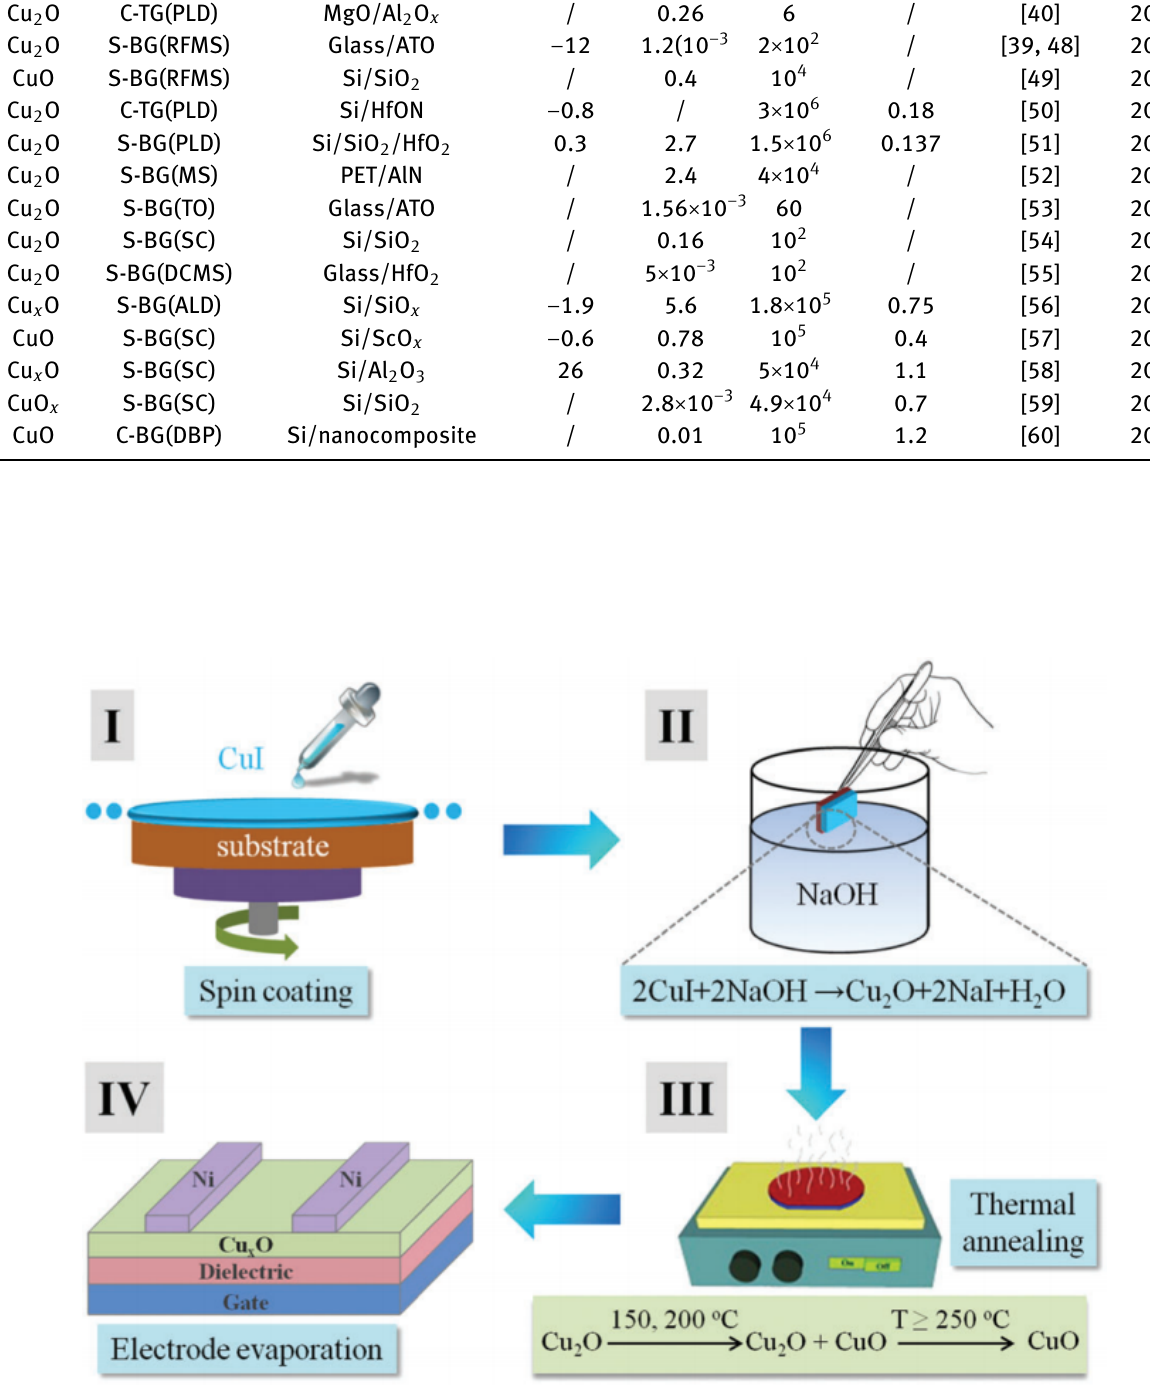
Figure 7: Fabrication process of the solution-processed Cu x O TFTs